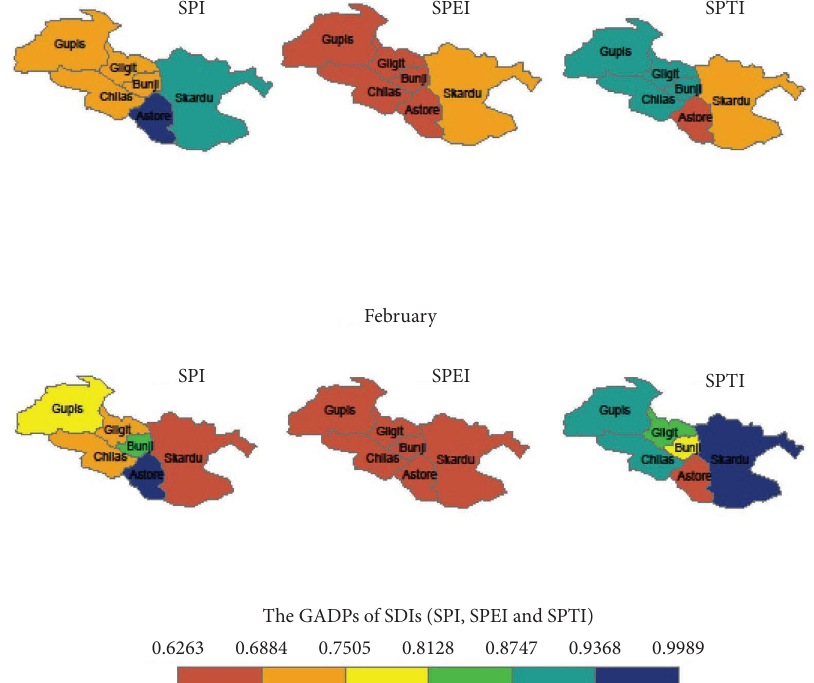
Figure 3: Spatial and seasonal dominance of diferent SDIs (the SPI, the SPEI, and the